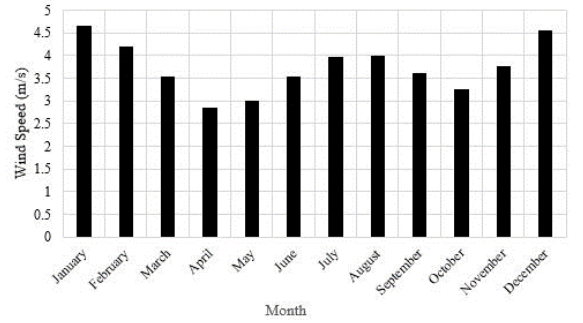
Figure 14. Average wind speed for each month over 24 years